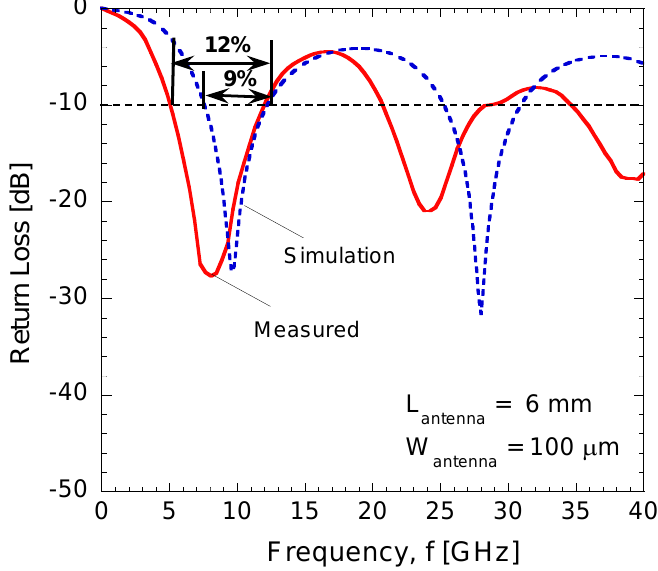
Figure 6. Measured and simulated return loss of the dipole